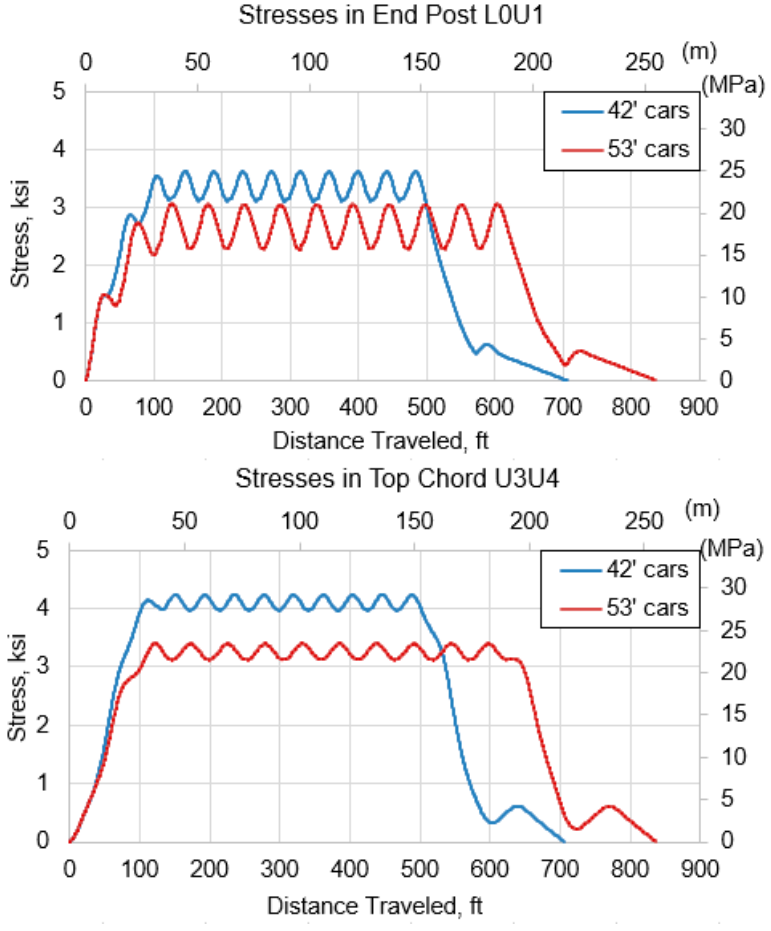
Figure 7. FEM stress histories in end post ( top ) and top chord ( bottom ) of 61-m (200-ft) span. The calculated stresses in the 61-m (200-ft) truss due to short railcars were 15 to 25% higher than for common length railcars in most of the primary members such as end posts, primary diagonals (U1L2), and top and bottom chords. The intermediate diagonals L2U3 and U3L4 experienced 13 and 7% higher stresses, respectively, due to common length railcars when compared to the short railcars. Figure 8 presents a comparison of predicted peak stresses for the main bridge components on the 61-m (200-ft) and the 33.5-m (110-ft) spans. In the 33.5-m (110-ft) long truss, predicted stresses were 7 to 26% higher due to short railcars when compared to the common length railcars for all truss members.